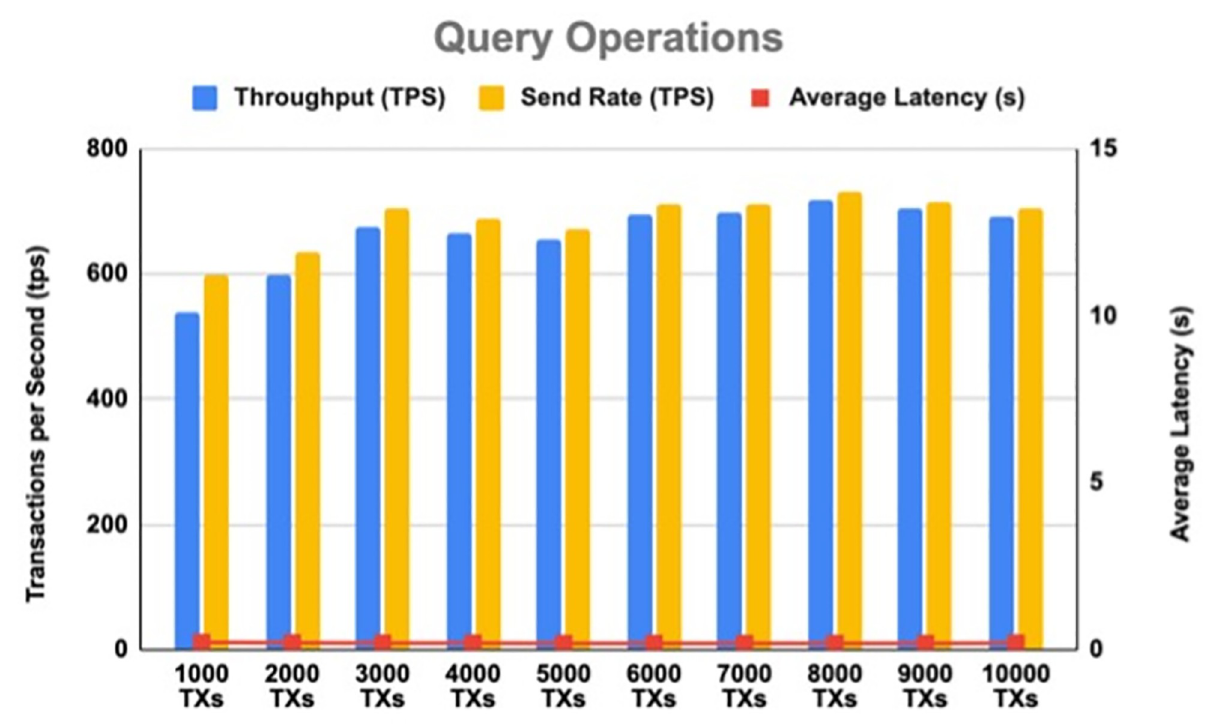
Fig 12. The impact of the increasing number of transactions on throughput and latency for Query